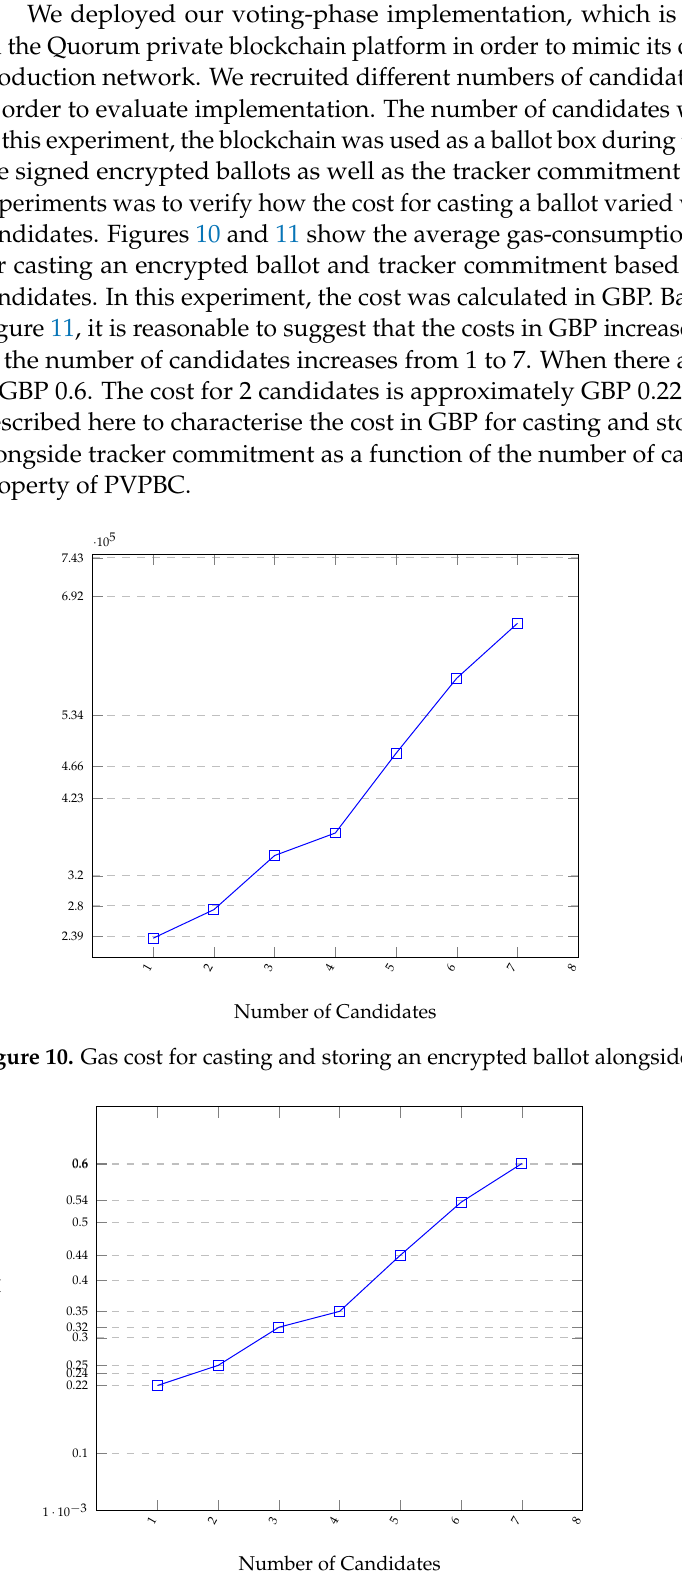
Figure 11. Cost in GBP for casting and storing an encrypted ballot alongside tracker